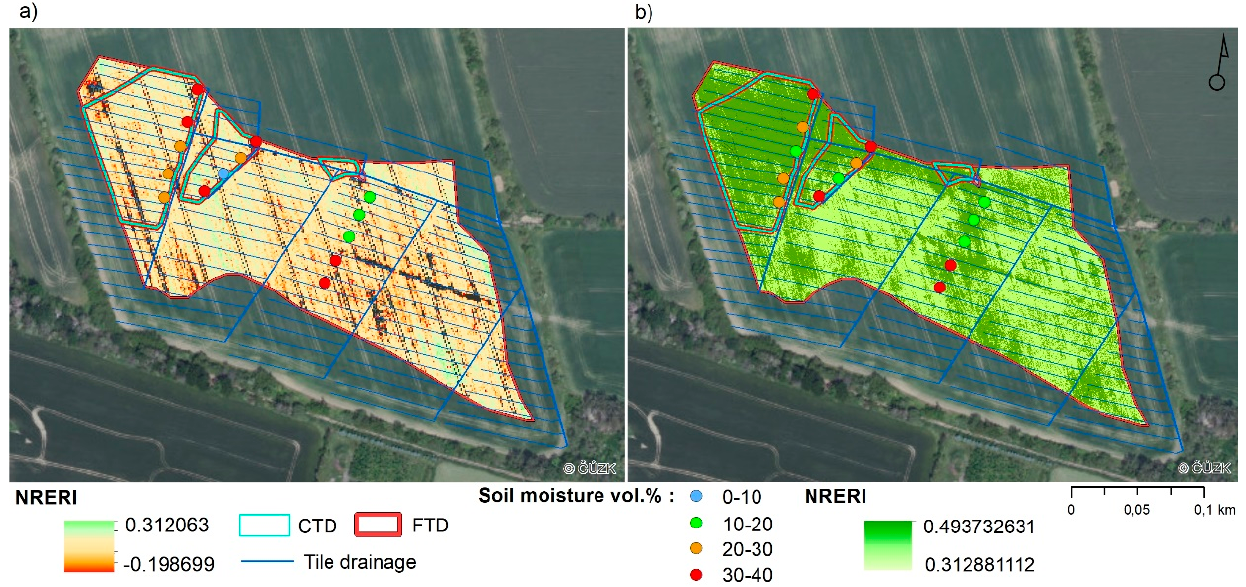
(ex-cluded outliers in black)and (b) 30 June 2021.